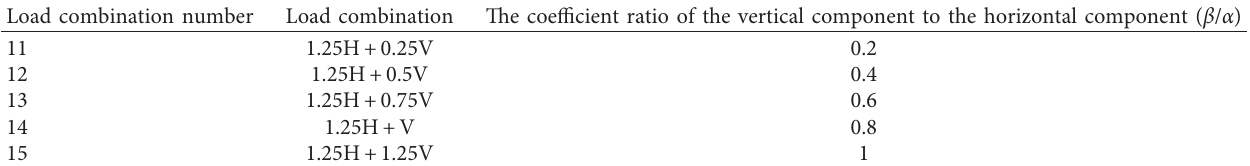
Table 11: Load combinations, including a horizontal component having coefficient 1.25 and a vertical component with a variable coefficient.